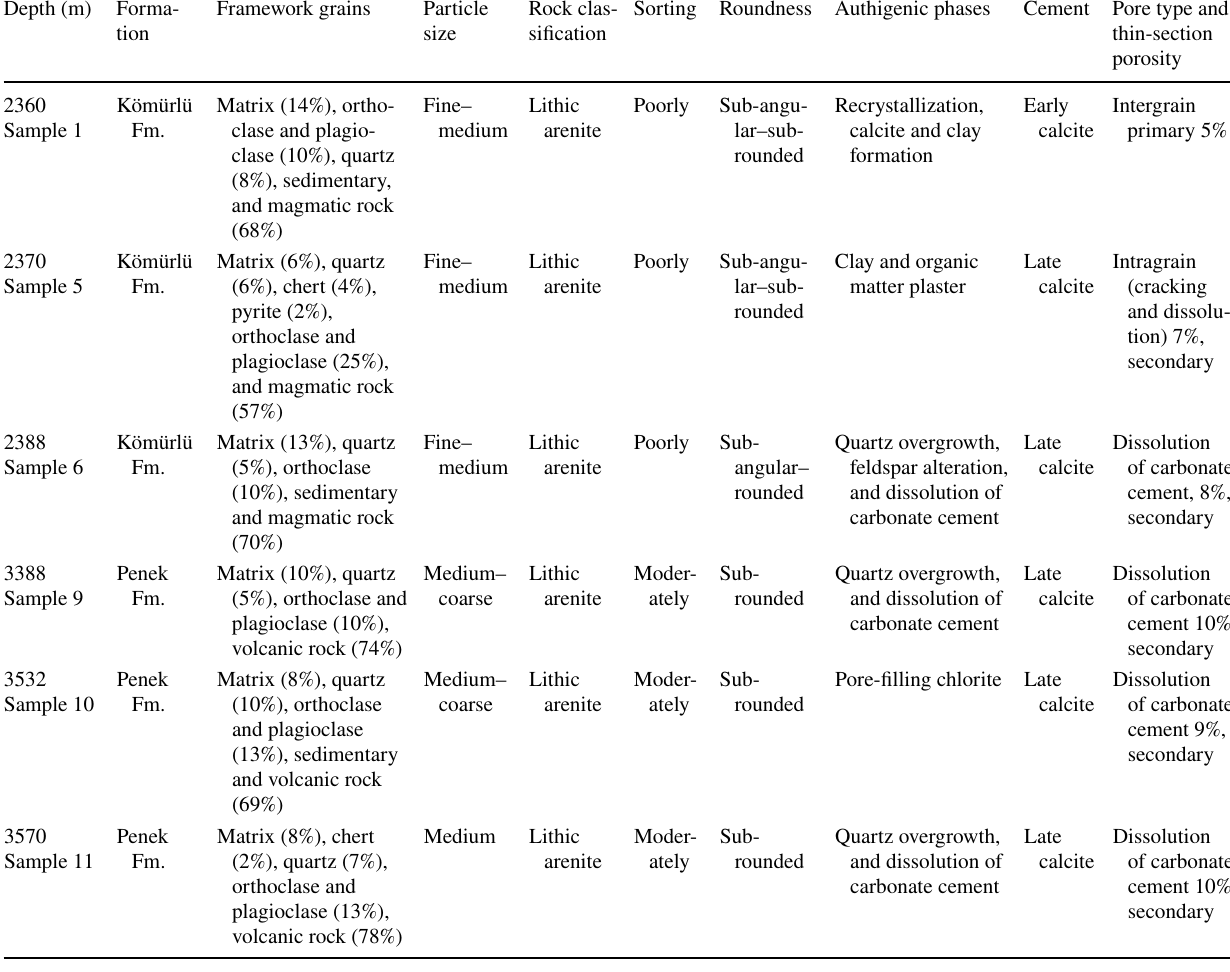
Table 1 Petrographic data of the Kömürlü and Penek Formation sandstones for a single well, Aşkale sub-basin Depth (m) Forma- tion